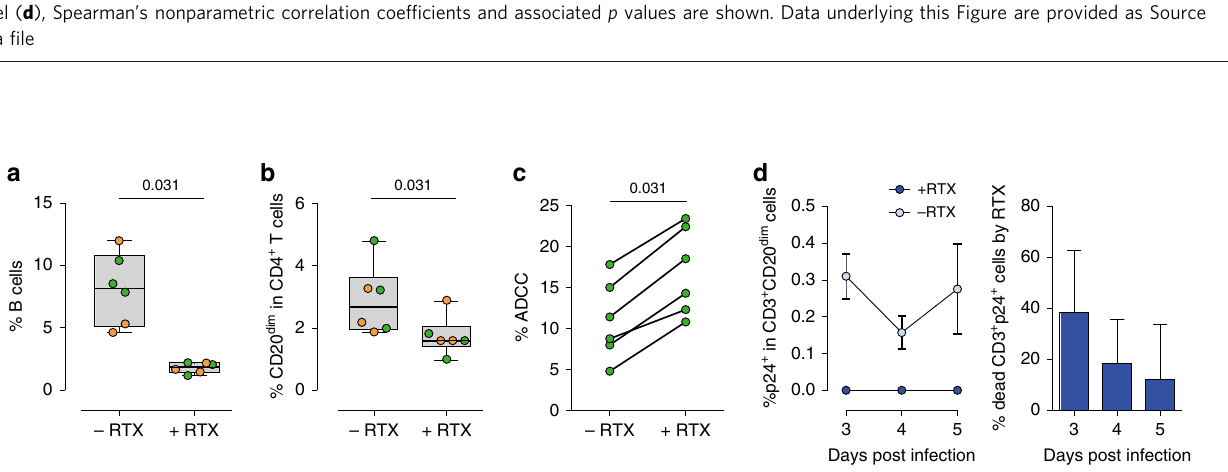
Fig. 5 Ex vivo infection upregulates CD20 expression. Unstimulated PBMCs from three uninfected donors were infected with HIV strain NL4.3. Infection was monitored by simultaneous staining of HIV RNA using the RNA FISH- fl ow assay and the viral protein p24 at days 3, 4, and 5. a Gating strategy used to monitor HIV infection and expression of CD20 dim . Previous sequential gates are represented in Supplementary Fig. 9. b Percentage of productively HIV- infected cells in CD3 + T cells (left panel) and in CD20 dim or CD20 − CD3 + T cells (right panel). c Expression of CD20 dim in infected and uninfected CD3 + T cells (left panel) and in the total CD3 + T cell population (right panel). d Correlation between the proportion of infected cells within the CD3 + T cell population and CD20 expression (left panel) and the mean fl uorescence intensity (MFI) of CD20 (right panel). e Percentage of HLA-DR and PD-1 in infected and uninfected cells expressing or not expressing CD20 dim . f Proportion of CD20 dim in infected cells expressing the CD4 cell receptor versus infected cells with marked downregulation of the CD4 receptor. In all panels, the mean and SEM value of three independent experiments is represented. In panel ( d ), Spearman ’ s nonparametric correlation coef fi cients and associated p values are shown. Data underlying this Figure are provided as Source